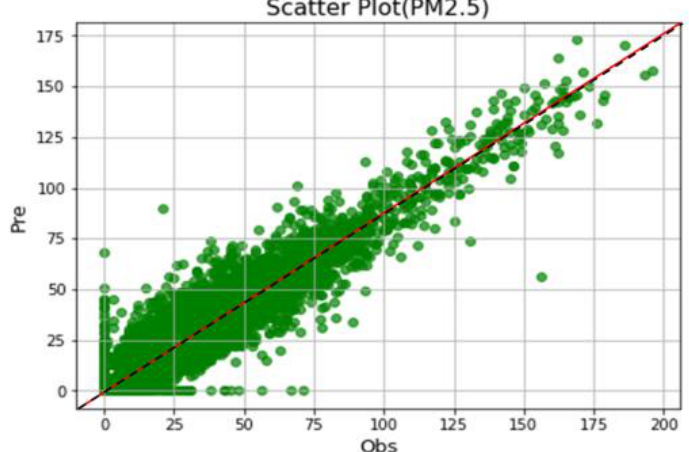
Figure 7. Comparison results of predicted fine dust with observations. The regression line of ob- served and predicted data is indicated in red.